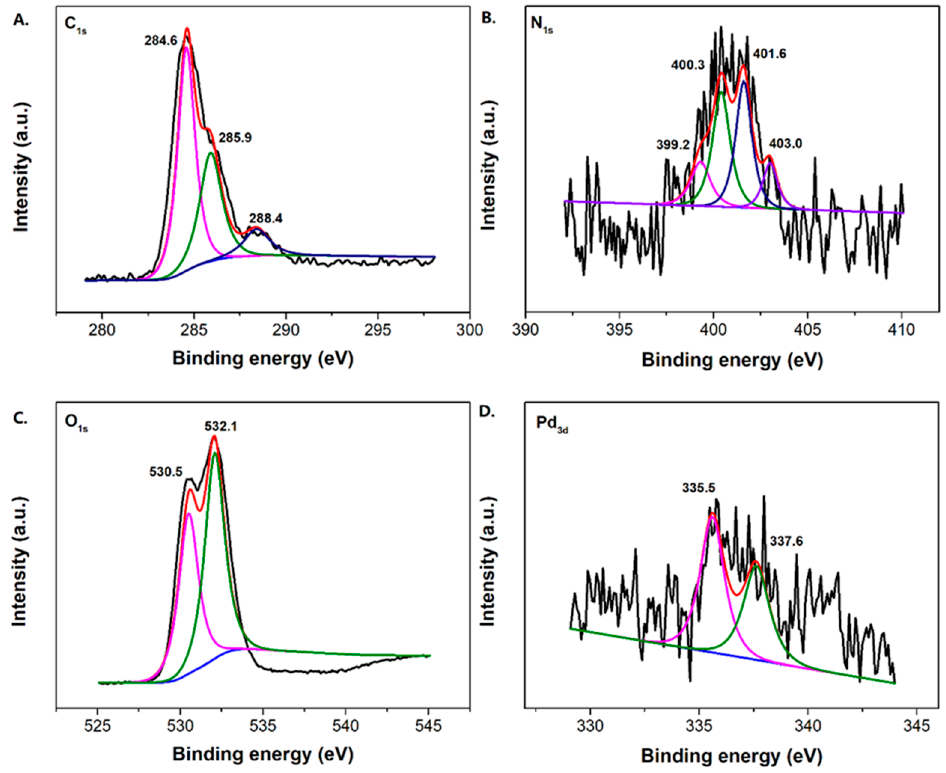
Figure 3. XPS spectrum of the C 1s ( A ), N 1s ( B ), O 1s ( C ), and Pd 3d ( D ) of the TiO 2 -MMT 60 /PCN 40 @Pd 0 nanocomposites.